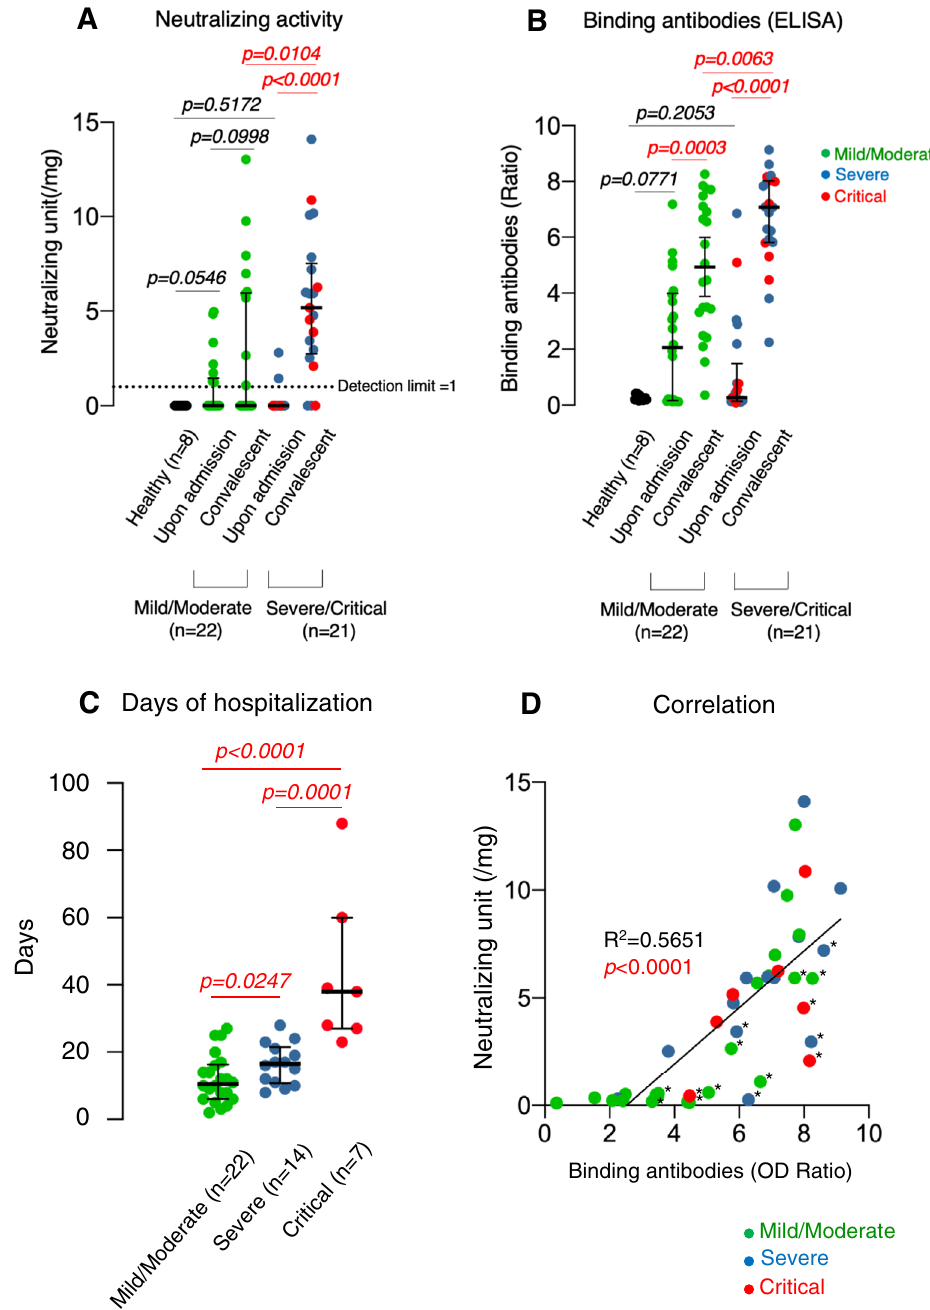
Figure 2. Changes in neutralizing activity of IgG fractions and the amounts of SARS-CoV-2-S1-binding antibodies. ( A , B ) IgG fractions from plasma (or serum) samples of all the 43 patients obtained upon admission and during convalescence were tested for their neutralizing activity and SARS-CoV-2-S1-binding antibody levels. The neutralizing activity of each IgG fraction was normalized by the activity of 100 µg IgG fraction of a patient D008 obtained at a convalescence time point, referred as to be 1 neutralization unit (Supplementary Fig. S2). The dashed line (1 neutralizing unit/mg) denotes the detection limit. The amounts of SARS-CoV-2- S1-binding IgG were measured using ELISA and shown by the ratios between the extinction of the sample and the calibrator (See “Materials and Methods” section for more details on the calculation. For disease severity definitions (Mild/Moderate: n = 22, Severe/Critical: n = 21), see the footnote in Table 1. p -value: Mann–Whitney U test. ( C ) Correlation of disease severity (Mild/Moderate: 22, Severe: 14, Critical: 7) and days of hospitalization. ( D ) Correlation of the SARS-CoV-2 binding IgG amounts and the neutralizing activity. Statistical analysis was performed and figures were generated using GraphPad Prism software version 8 (https ://www.graph pad.com/ scien tific -softw are/prism /) (La Jolla,